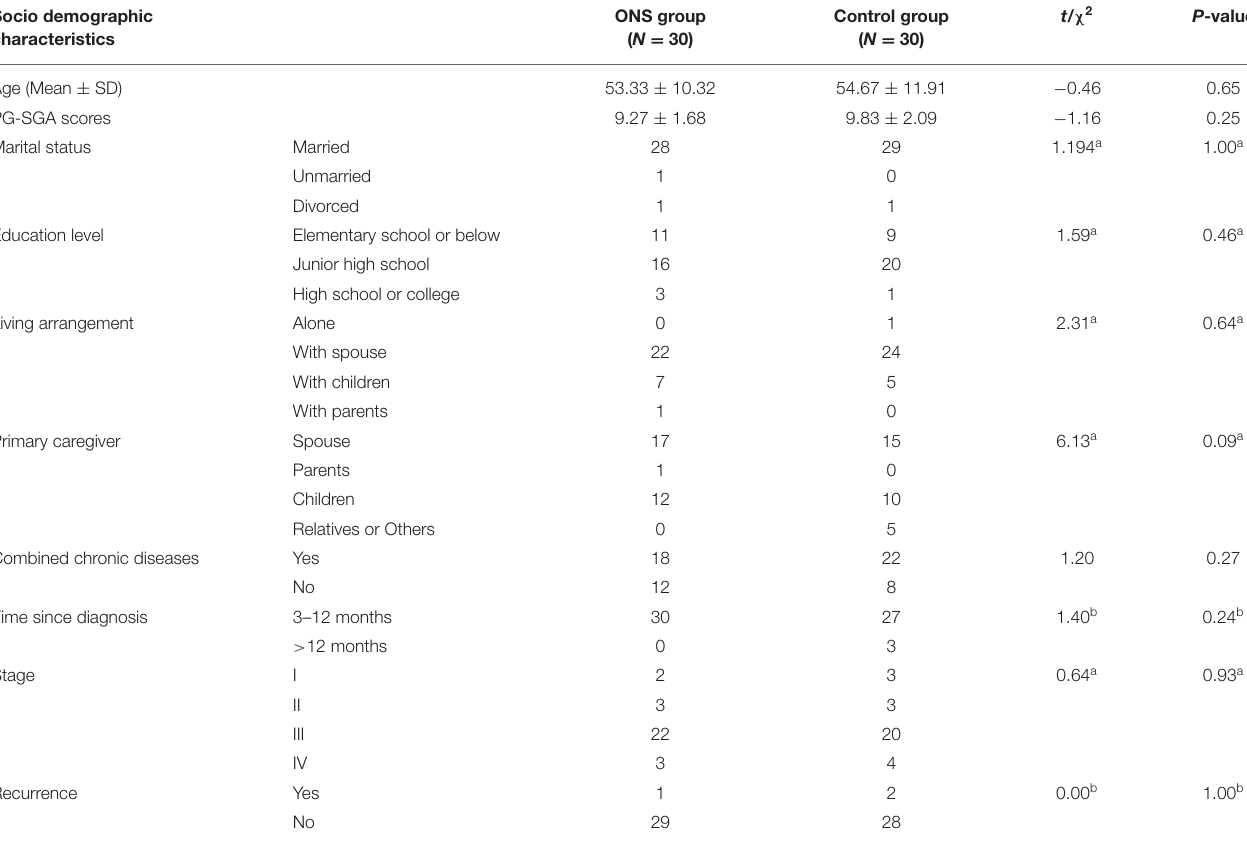
TABLE 1 | Socio-demographic characteristies of study participants. Socio demographic characteristics